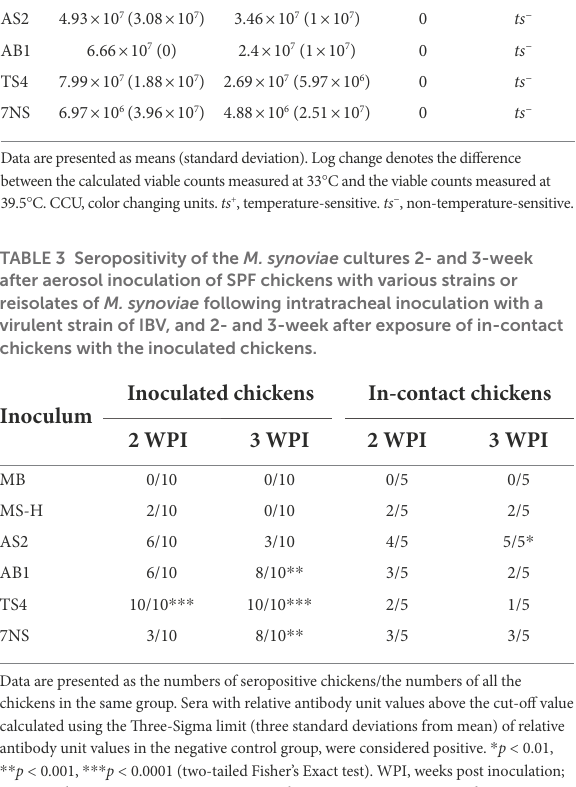
reisolate were significantly ( p < 0.01) higher than all other groups at 2- and 3-week post inoculation (Supplementary Figure S1).